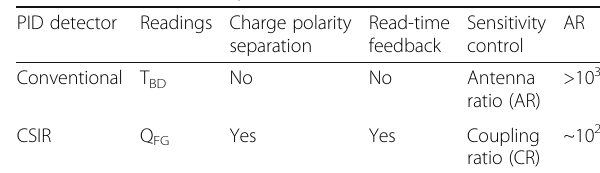
Table 2 Performance summary of the new charge splitting in situ recorder (CSIR) for monitoring plasma charging damage in